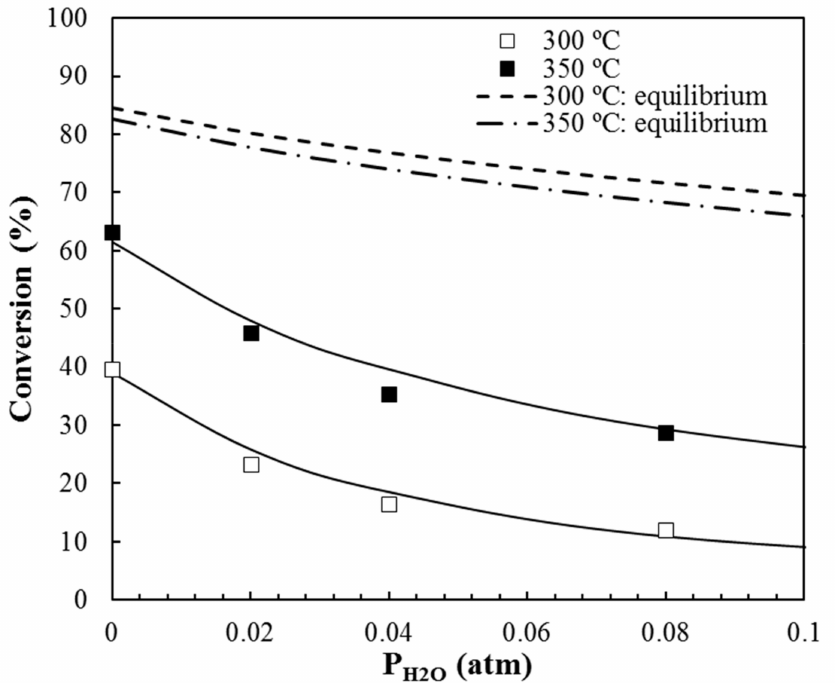
Figure 7. Methanol conversion as a function of di ff erent water partial pressures at 300 and 350 ◦ C for OS2 monolith. P MeOH = 0.03 atm, W / F MeOH = 0.1 g · s / µ mol. Dots: experimental data, lines: Langmuir-Hinshelwood model fitting; dash lines: methanol equilibrium